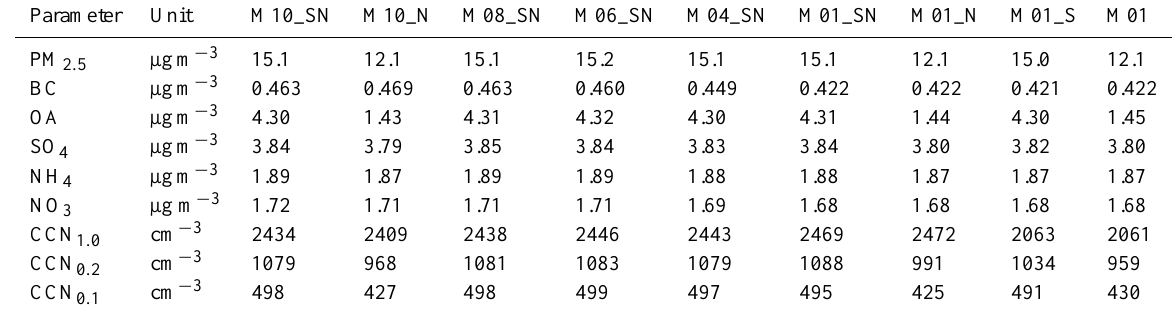
Table 3. Period- and domain-averaged aerosol mass and number concentrations at an altitude of about 1km (sigma level of 0.895) at noon. Parameter Unit